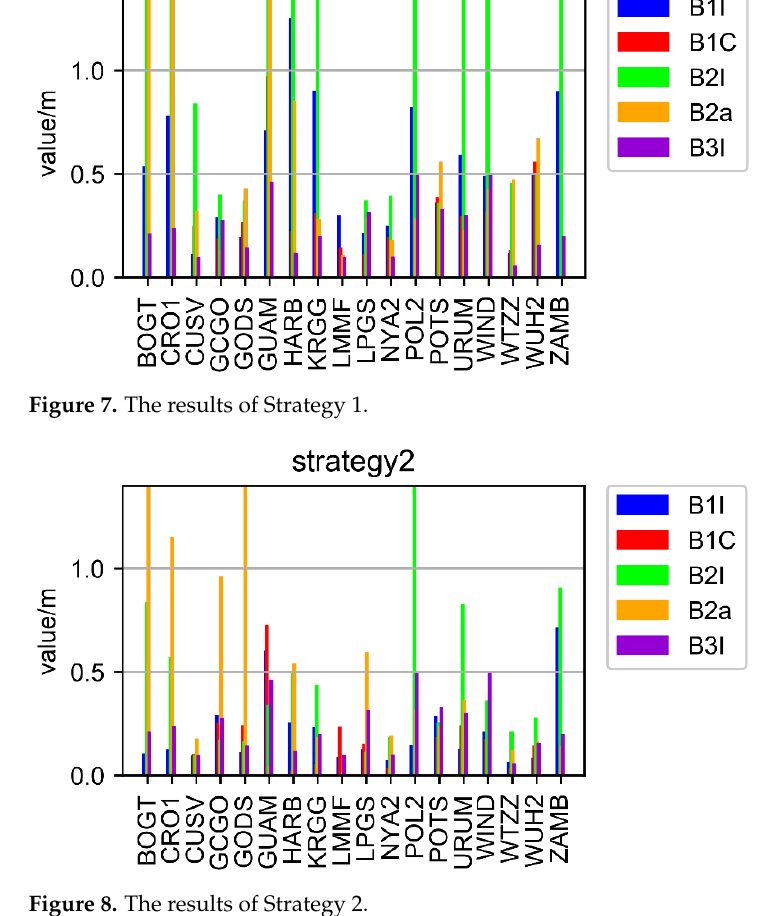
Figure 8. The results of Strategy 2.